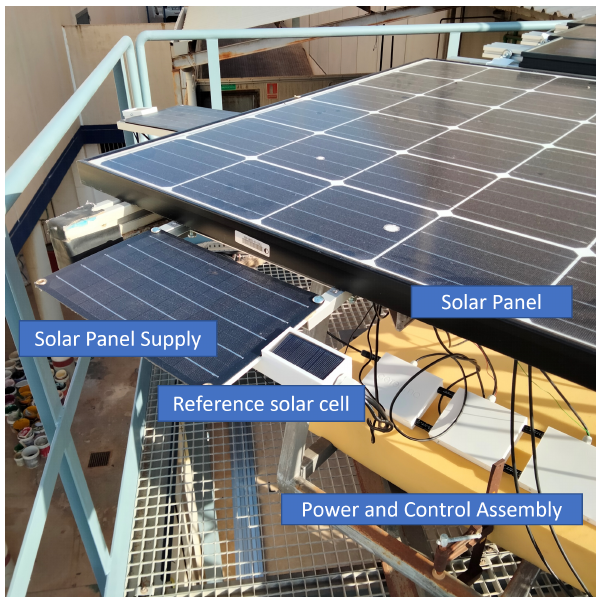
Figure 10. Case study. Example of field test campaign. Charging solar panel and reference cell assembled to the monitored PV module panel.